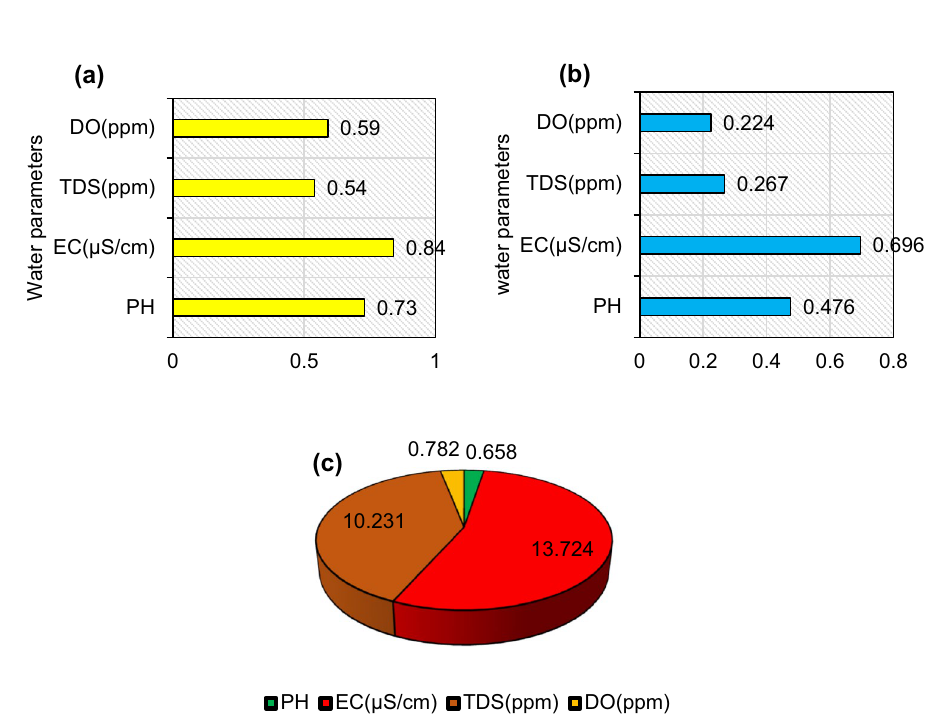
Fig. 7 Coefficient correlation; b Nash–Sutcliff efficiency; c root mean square error by